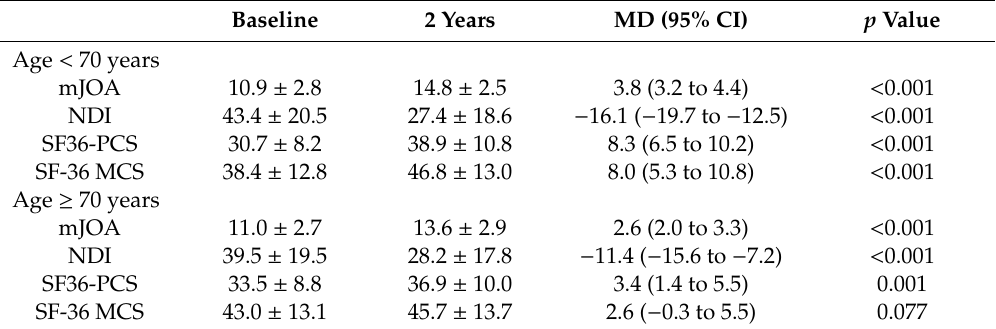
Table 2. Functional, disability, and quality of life assessment scores of both cohorts at the two-year interval. Baseline 2 Years MD (95% CI) p Value